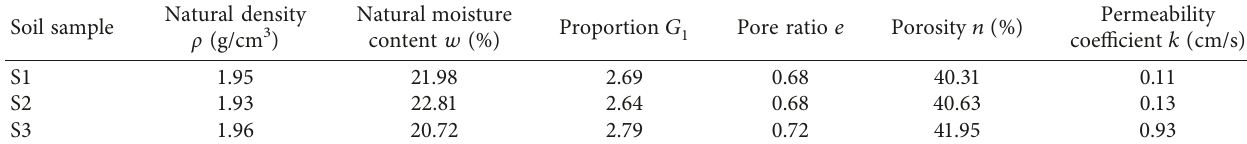
Table 1: Physical properties of sand.